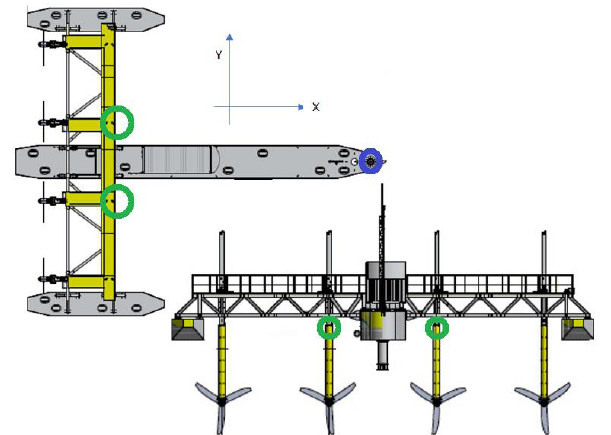
Fig. 1. SME PLAT-I Layout. Green circles indicate ADV and ECM locations, Blue circle is the mooring turret and datum for instrument locations at the